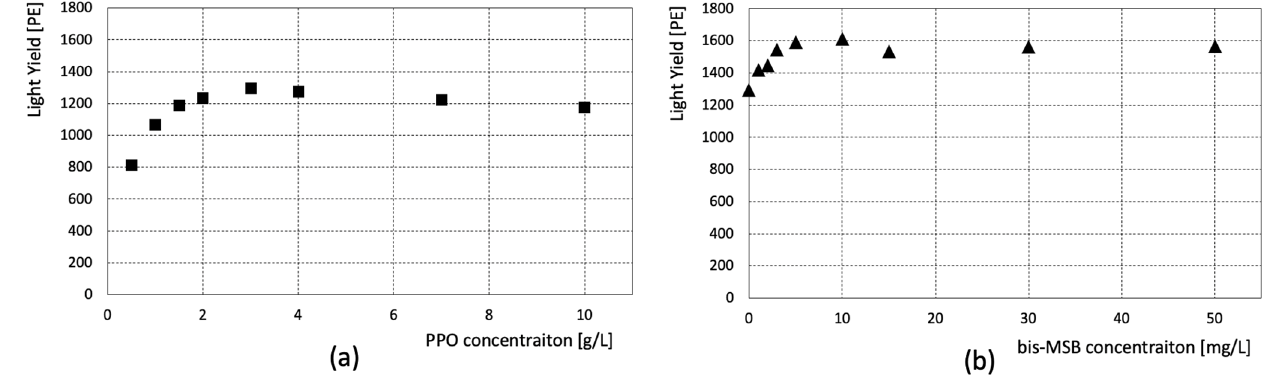
Figure 4. Observed light yield of sample B3, obtained from two H7195 PMTs using the setup shown in Figure 3a. A clear PE correlation is observed between the two PMTs. The inset presents a 1D projection plot for the observed PE. The upper (lower) inset corresponds to the PE distribution of PMT-B (PMT-A). Each PE distribution is fitted to determine the Compton edge.